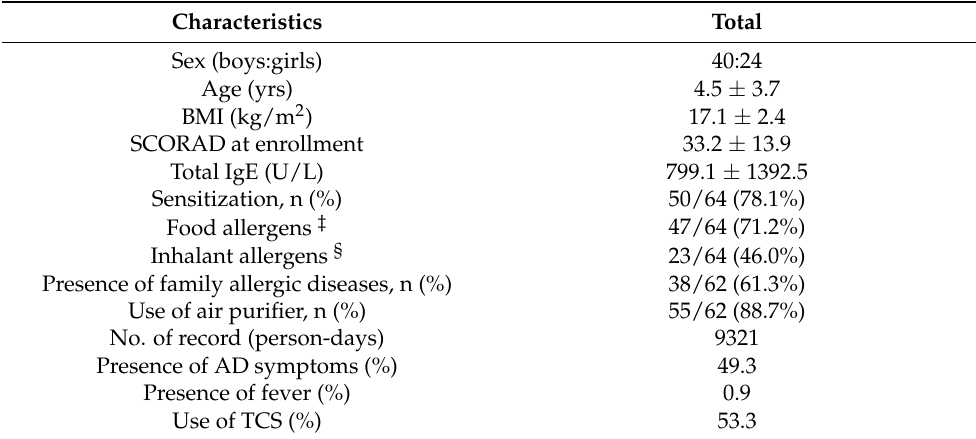
Table 1. Characteristics of the subjects in this study ( n = 64)